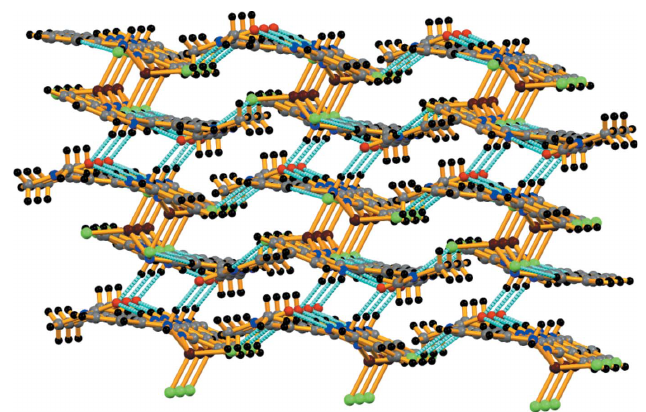
Figure 3 Supramolecular view along the b axis of the crystal structure of the title